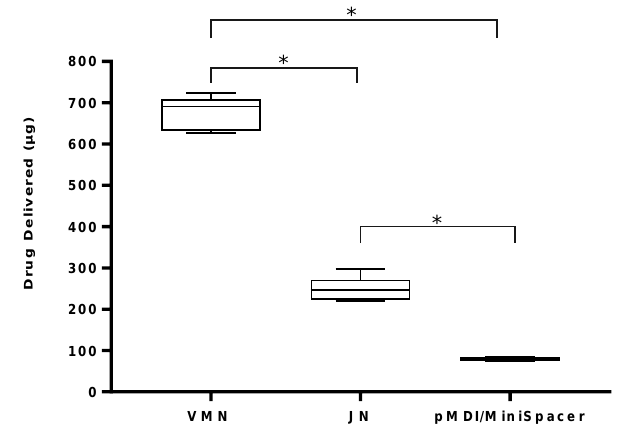
Figure 5. Aerosol drug delivery using standard adult settings during simulated mechanical venti- lation with passive humidification (HMEF). Three different devices, VMN, JN and pMDI, using a MiniSpacer, were tested. pMDI actuation was at the start of inhalation. Results are presented as mean ± SD µg drug delivered. * Denotes statistical significance at p < 0.0001.